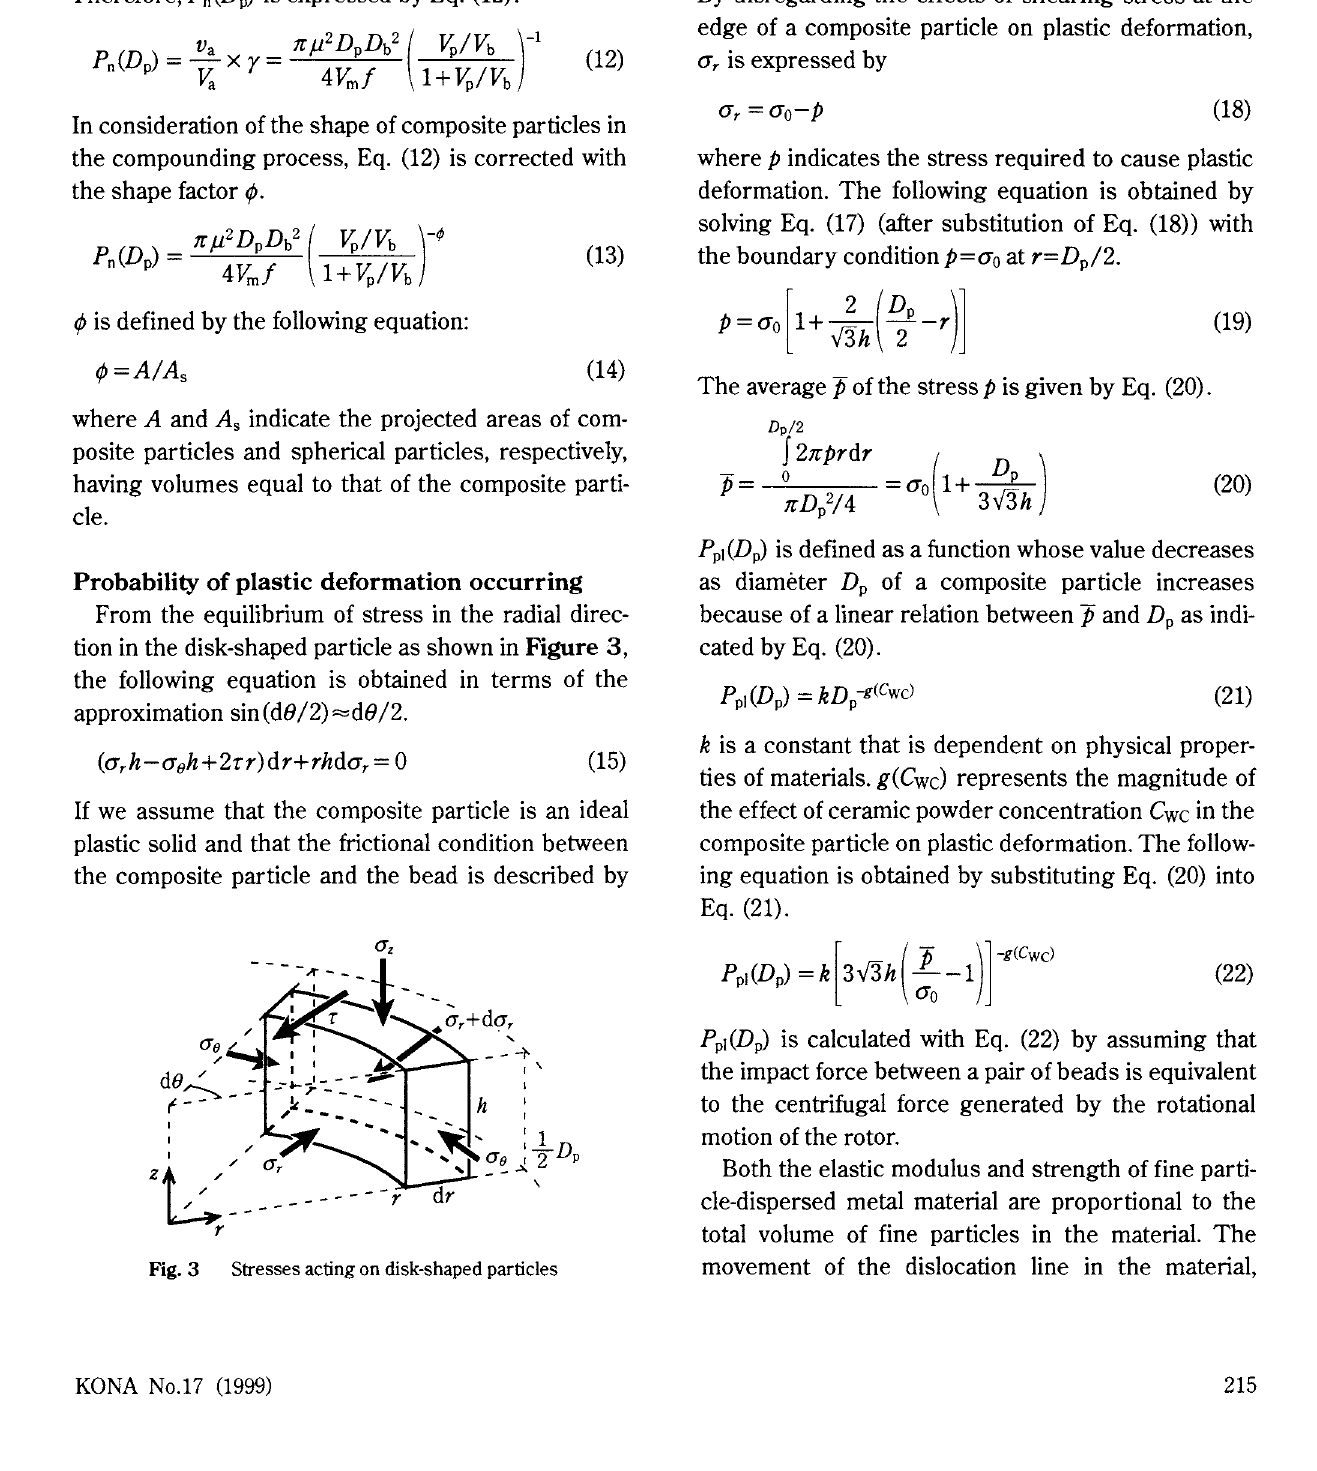
Fig. 3 Stresses acting on disk-shaped